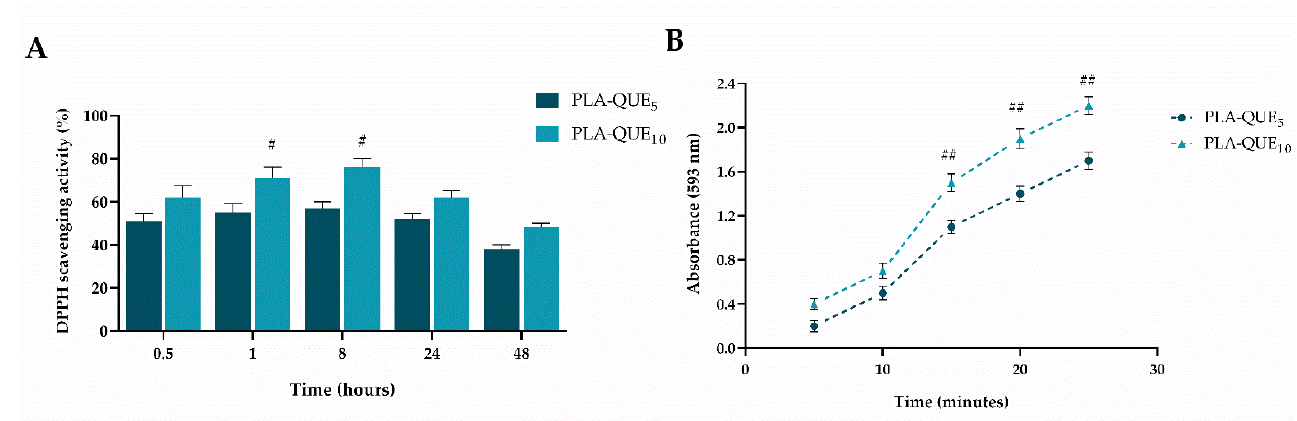
Figure 4. DPPH scavenging activity ( A ) and ferric reducing power (FRAP assay) ( B ) of QUE-loading membranes at different QUE concentrations (5% and 10%). For each sample, six different experiments were carried out, and the results are expressed as the mean of the values obtained (mean ± SD). Statistically significant variations: # p ≤ 0.05 and ## p < 0.01 versus PLA-QUE 5 .